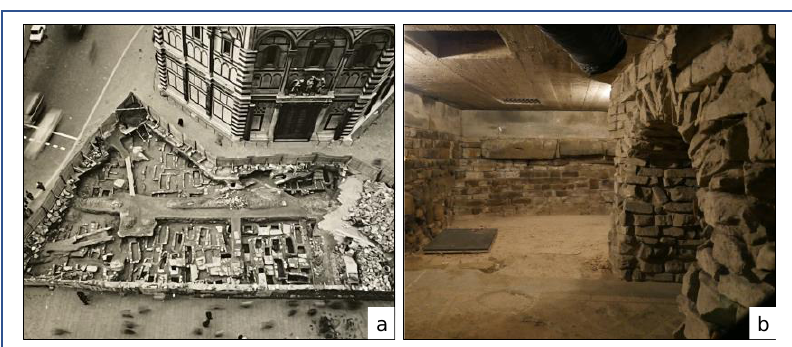
Figure 8. ( a ) The burial ground revealed during the excavations of 1971 – 1972 in Piazza del Duomo (Firenze, SABAP Fi-Pt-Po. Courtesy of the Ministry of Cultural Heritage and Activities); ( b ) Excavations under the SW sector of the baptistery. The modern concrete at the roof is clearly visible.